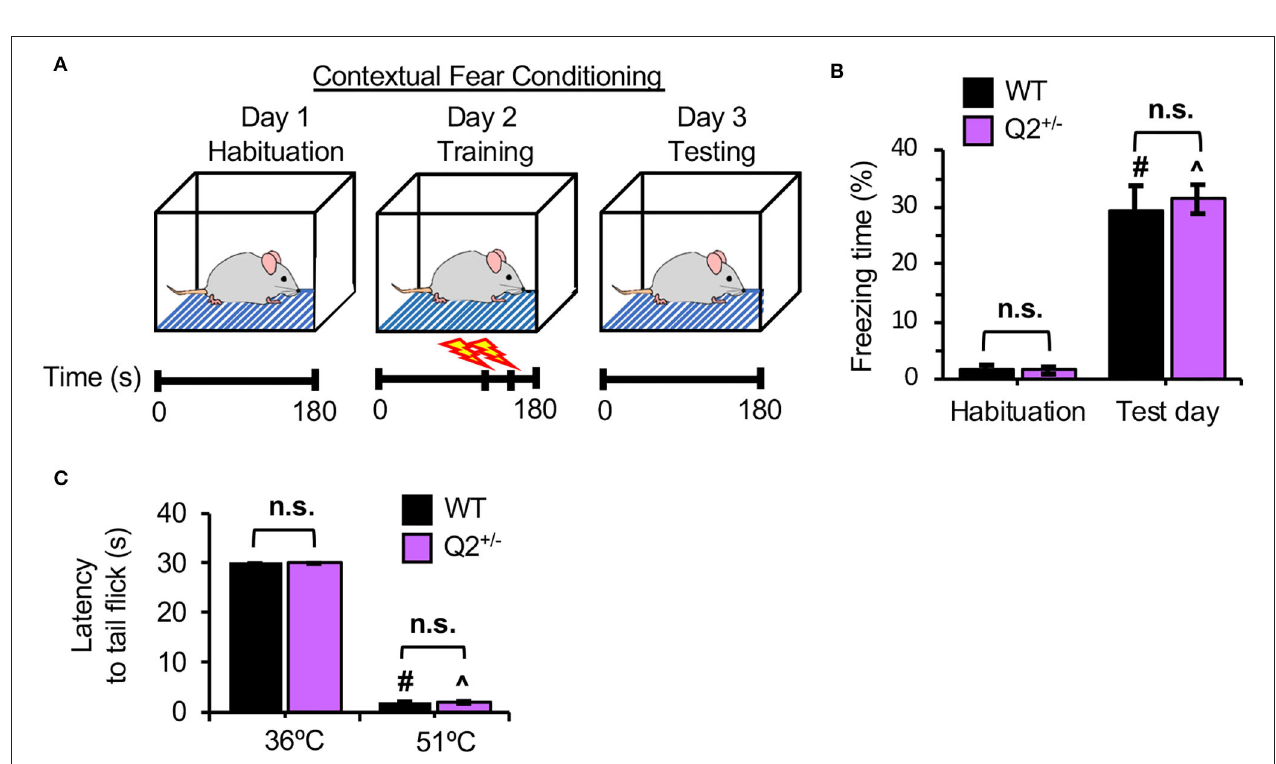
FIGURE 2 | Heterozygous loss of Potassium Voltage-Gated Channel Subfamily Q Member 2 ( KCNQ2 ) in mice does not affect fear memory retention and thermal pain threshold. Separate cohorts of KCNQ2 + / + (wild-type; WT) mice and KCNQ2 + / − (Q2 + / − ) mice at age 4–6 months were subjected to contextual fear conditioning (CFC) test and tail-flick assay. (A) The design of the CFC test. A mouse is first habituated in a CFC chamber for 180s. Next day (training day), the mouse is placed in the chamber for 180s and receives a mild foot shock (0.5mA, 2s) at 120s and 150. On 1 day after foot shocks (Test day), a mouse is returned to the chamber for 180s. Freezing time is recorded on habituation and retention days. (B) Freezing time is the percentage (%) of total time spent in the chamber. The number of mice used: WT ( n = 20 that includes 10 male mice and 10 female mice) Q2 + / − ( n = 20 that includes 10 male mice and 10 female mice). Post-hoc Tukey test results are shown for the habituation day vs. the test day in WT ( # p < 0.001) and in Q2 + / − ( ∧ p < 0.001). (C) The average latency to tail-flick. In tail-flick assay, a mouse is restrained in a 50ml conical tube and the tail is lower into a 36 ◦ C water bath and the latency to tail-flick is recorded for 30s. The procedure is repeated with a 51 ◦ C water bath. All mice reached 30s latency at 36 ◦ C. The number of mice used: WT ( n = 20 includes 10 male mice and 10 female mice), Q2 + / − ( n = 20 includes 9 male mice and 11 female mice). Data represent the mean ± SEM. Post-hoc Tukey test results are shown for 36 ◦ C vs. 51 ◦ C in WT ( # p < 0.001) and in Q2 + / − ( ∧ p < 0.001). No significant difference between genotypes was found (n.s.). The individual data points are shown in Supplementary Figure S2